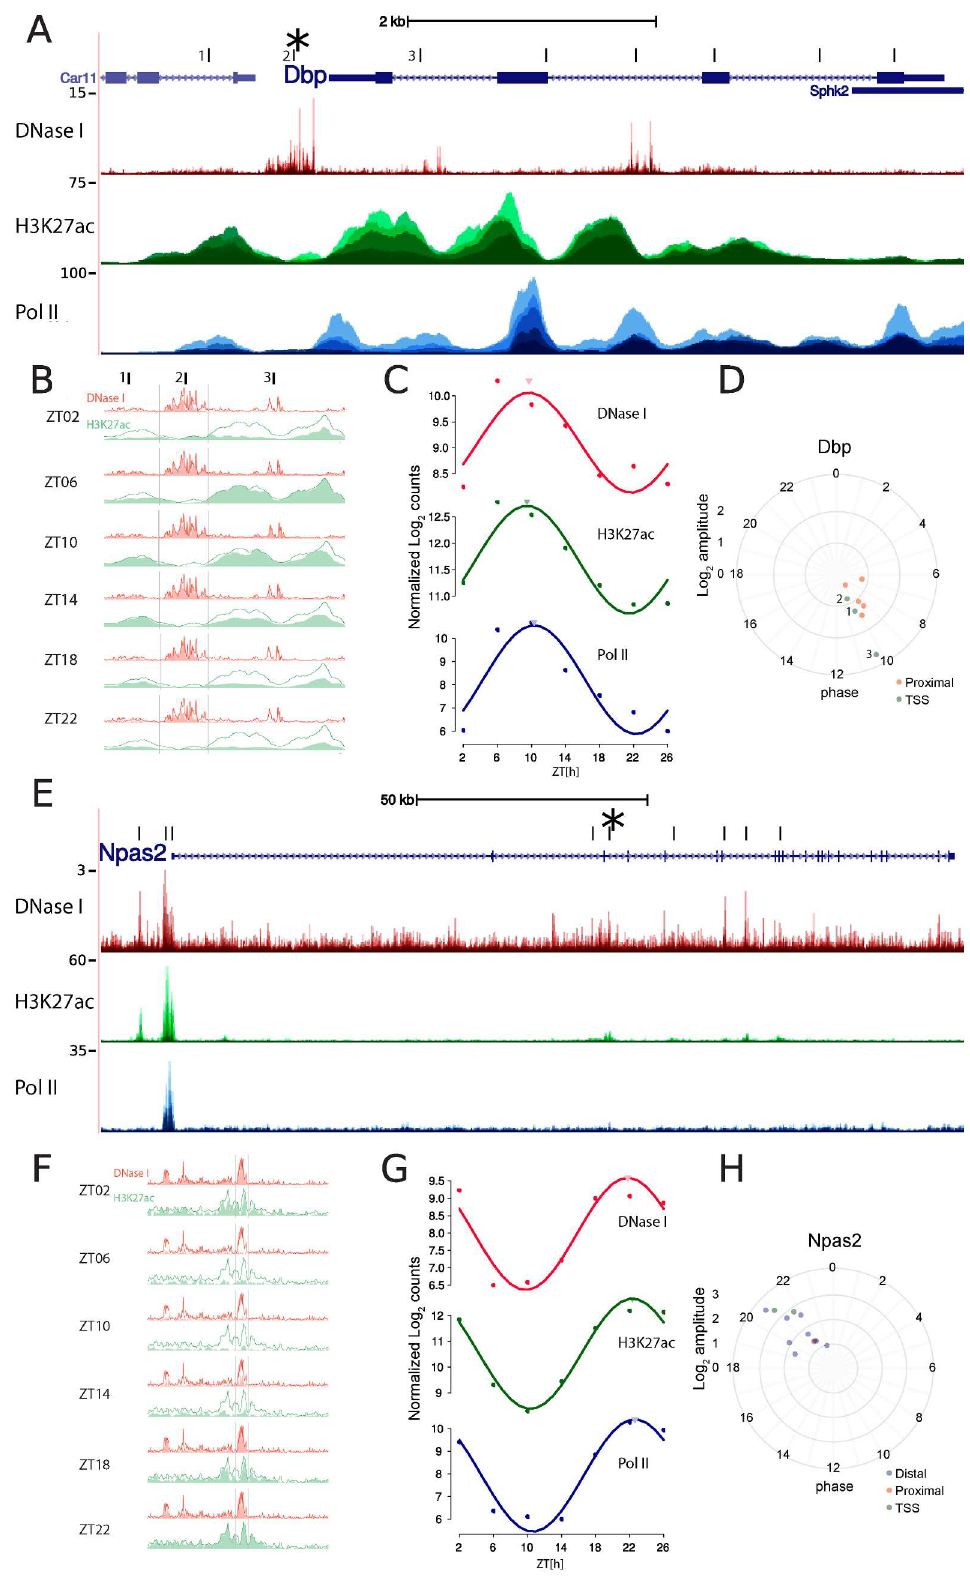
Fig 1. DNase I hypersensitivity is rhythmic during diurnal cyclesin mouse liver. A. DNase I hypersensitivity, RNA polymerase II (Pol II) density, and H3K27acenrichment at the Dbp locus. The DNase I track shows the frequency at which nucleotide-resolvedDNase I cuts, while H3K27acand Pol II chromatin